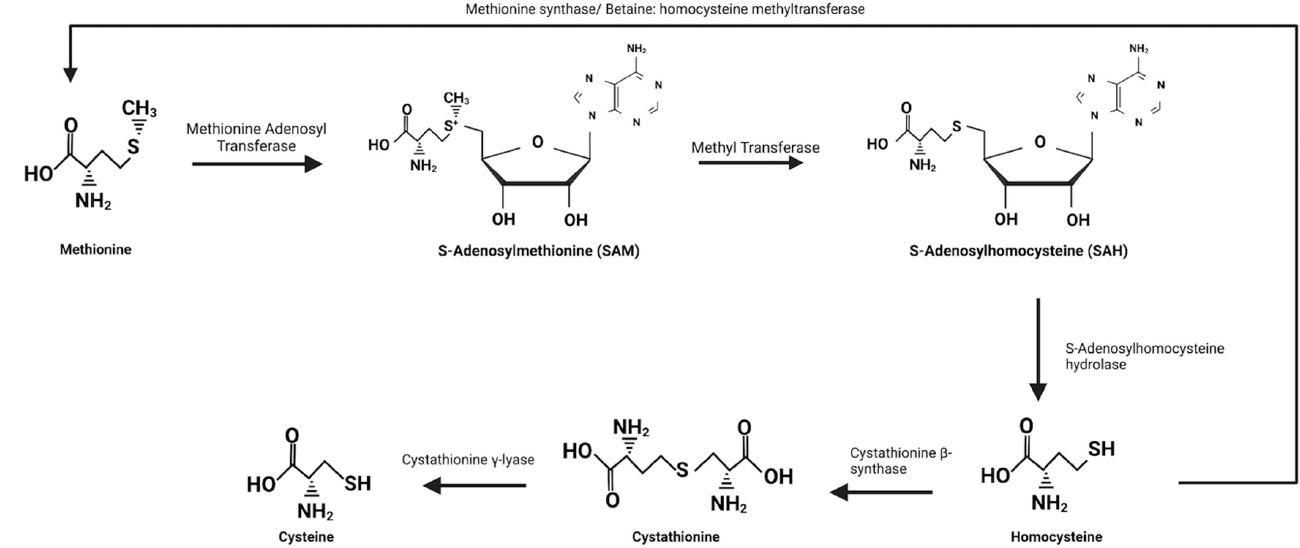
Figure 6. The conversion of methionine to homocysteine and cysteine. Conversion of methionine to S-adenosylmethionine (SAM) begins with methionine adenosyl transferase which is an ATP-dependent reaction requiring the removal of all three phosphate groups from ATP. SAM then donates its methyl group to a methyl acceptor using a methyl transferase to form S-adenosylhomocysteine (SAH). SAH is hydrolyzed into homocysteine and adenosine by S-adenosylhomocysteine hydrolase which marks the end point of the transmethylation reactions. At this point homocysteine may be methylated by either methionine synthase or betaine: homocysteine methyltransferase to be converted back into methionine or undergo transsulfuration to form cysteine. Transsulfuration begins with the conversion of homocysteine to cystathionine by cystathionine β -synthase and then ends with the formation of cysteine from cystathionine by cystathionine γ -lyase.